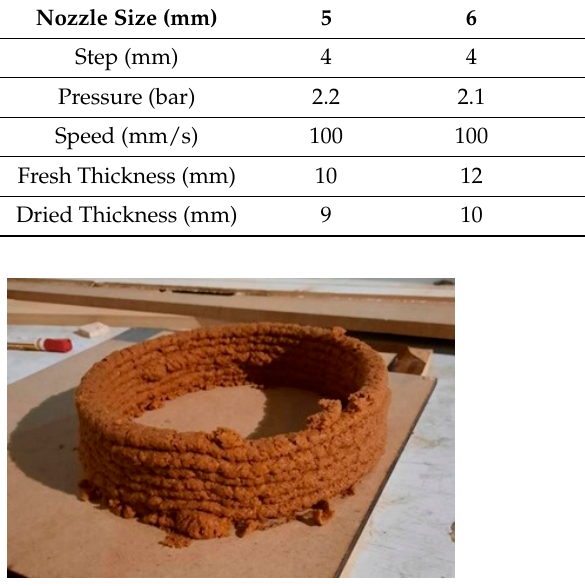
Figure 9. The initial extrusion experiment (Image credit: Authors).